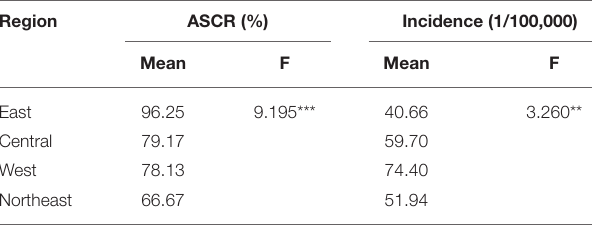
TABLE 2 | Disparity analysis of ASCR and incidence by region in